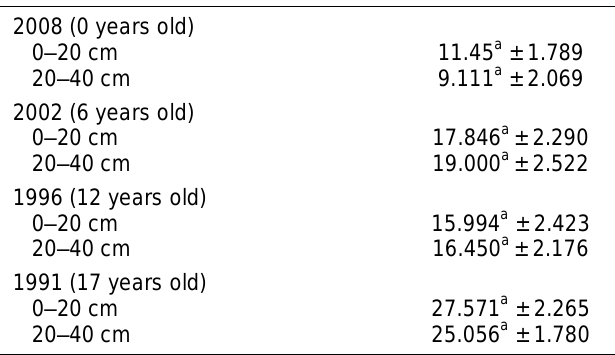
Soil CEC of a Rehabilitated Forest Soil (between Depths) Age of Rehabilitated Forest Soil